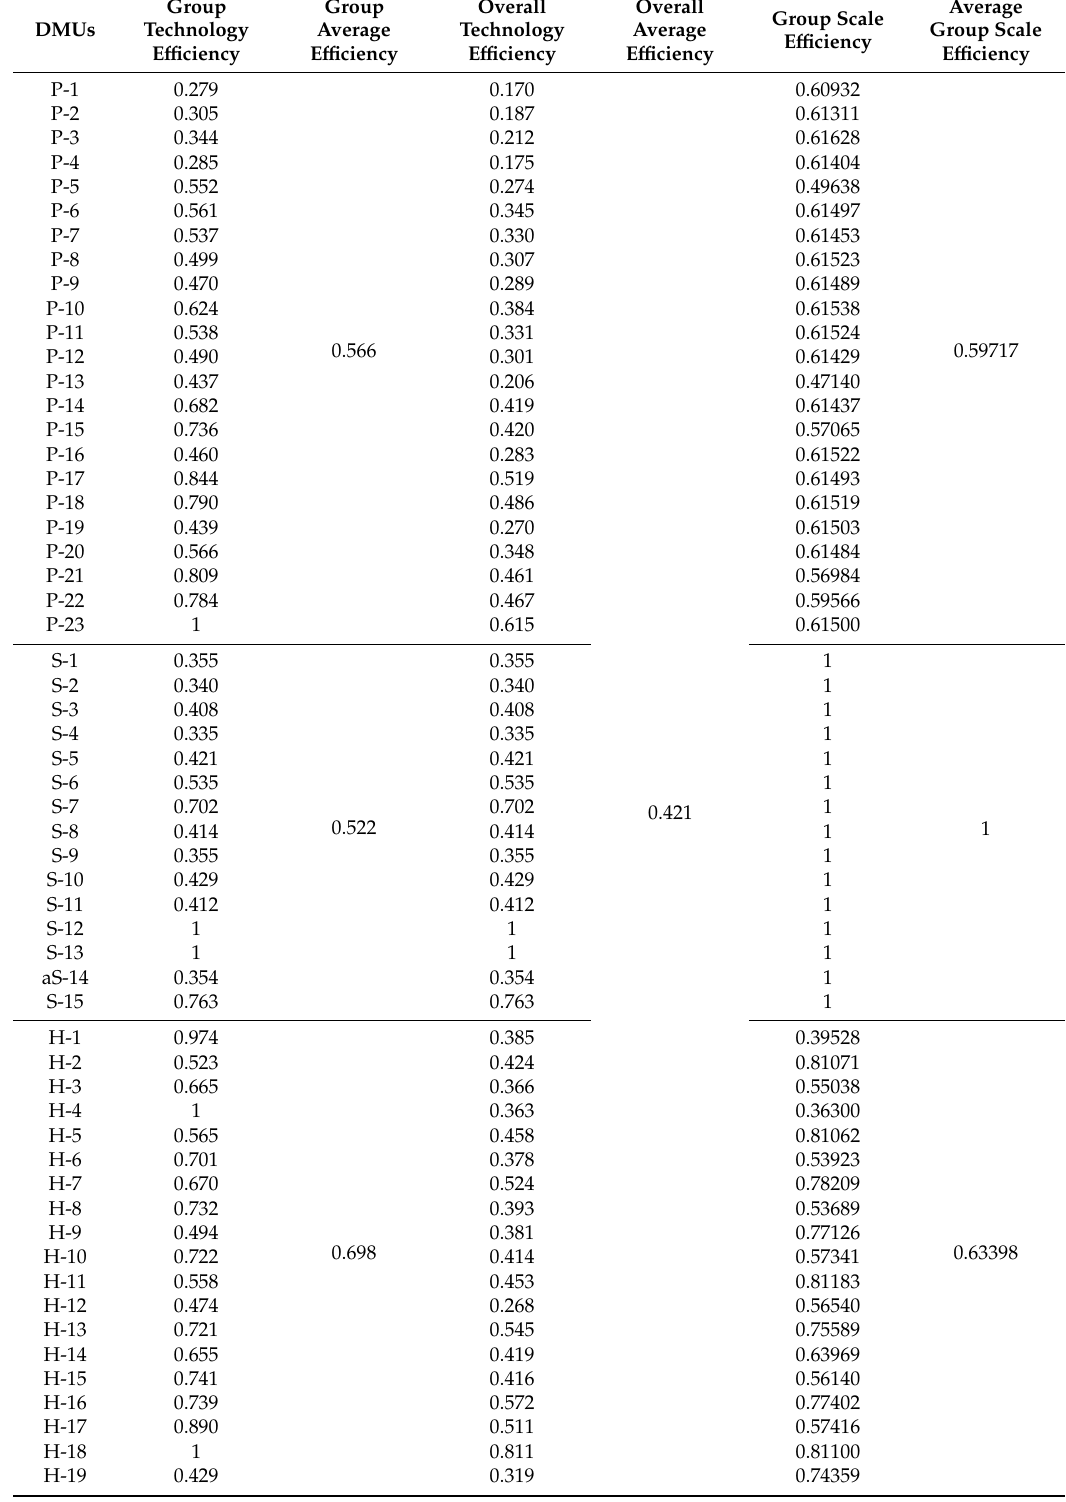
Table A3. Bulk overall shipping group each item e ffi ciency